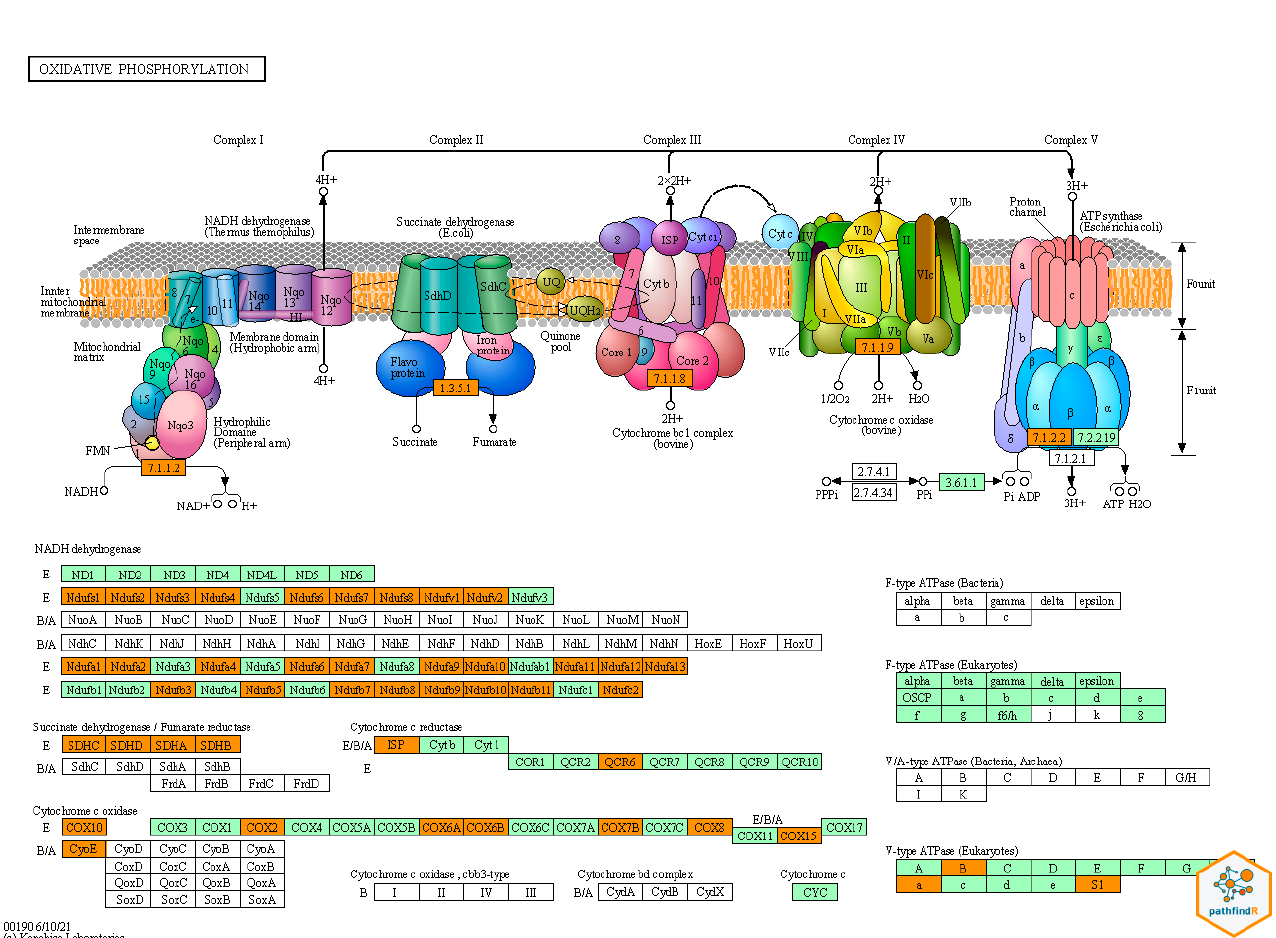
Figure 4. KEGG map of the oxidative phosphorylation pathway. Green genes are the most important genes in the pathway. In orange, the genes that appear in our